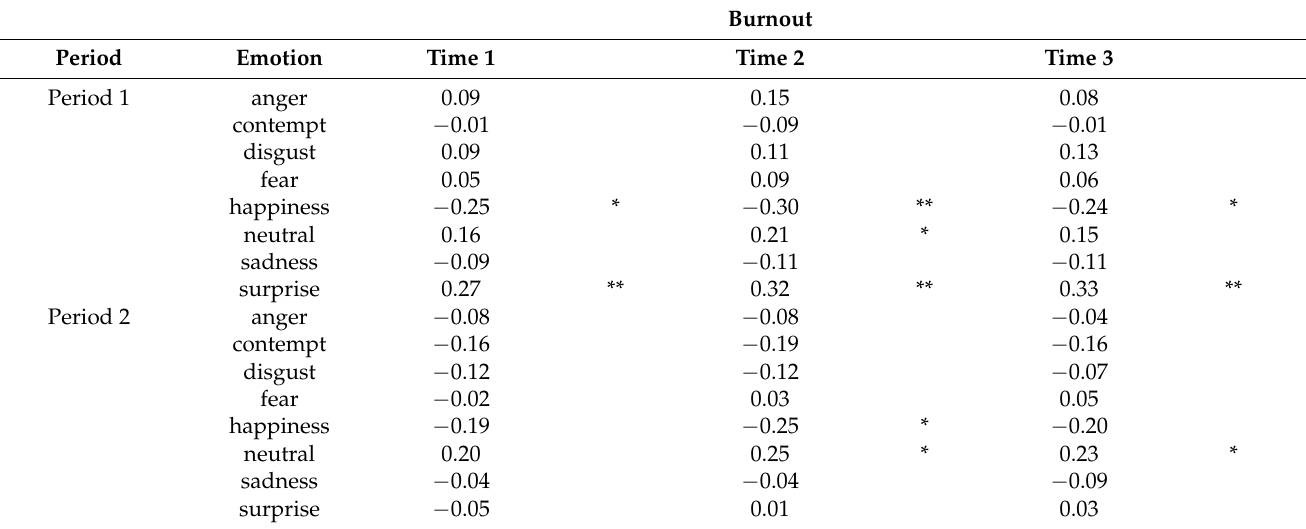
Table 4. Pearson correlation coefficients between burnout and emotions.